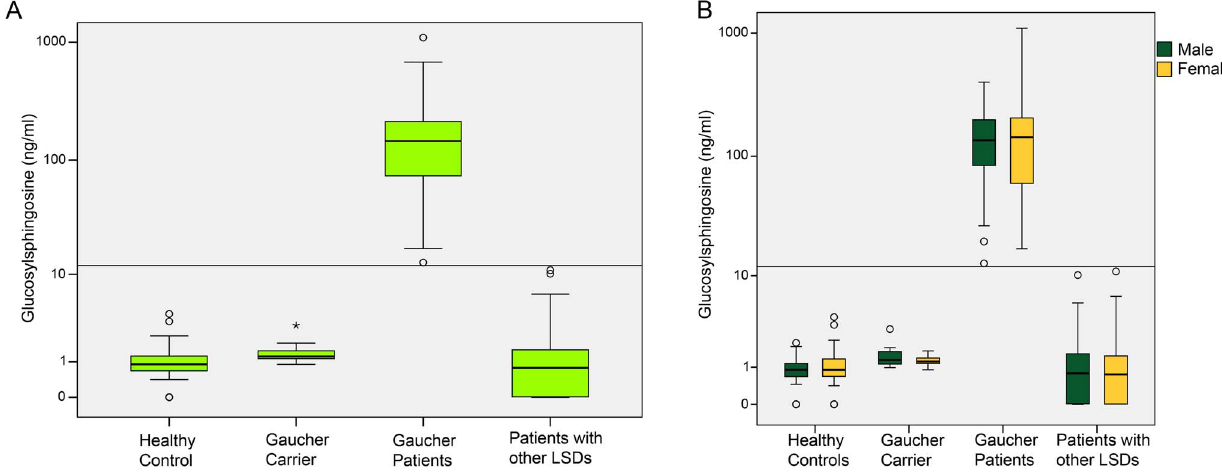
Figure 3. Glucosylsphingosine levels in sub-cohorts. Level of Glucosylsphingosine is illustrated in the entire cohort (A) and separated according to gender (B). Glucosylsphingosine in GD patients was compared to healthy controls, GD carriers and patients with other LSDs. The horizontal bar marks the cut-off for pathological Glucosylsphingosine values above 12 ng/ml. Notably, only GD patients feature pathological values of Glucosylsphingosine and additionally Glucosylsphingosine is not gender-dependent (B; dark green representing males and orange females).